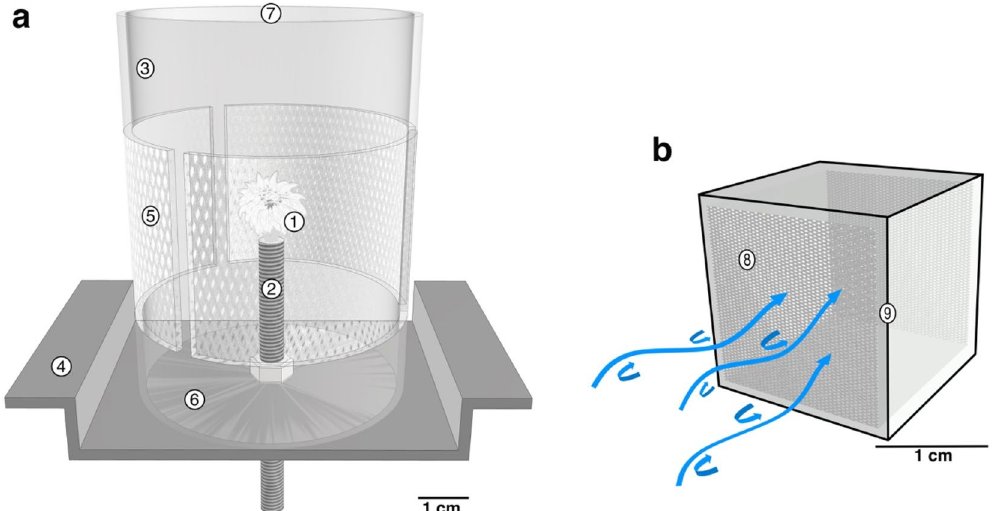
Figure 8. Schematic drawing of the ( a ) cylindrical plastic container and the ( b ) flow-through cube in the holding tank. ( a ) Reproductive polyp (1) glued onto a polyethylene screw (2), and placed in a cylindrical (7.2 cm high, 5.4 cm ø) plastic container (3), which was screwed onto a plastic holder (4). The plastic container had three side windows covered with mesh (100 µm) (5) to allow water exchange. A closed bottom (6) and an open top (7), which rose 1 cm above the water surface ensured retention of larvae. ( b ) Larvae collected from the container were placed into a cube with the upstream and downstream side covered with a 100 µm mesh (8), whereas the top, floor and walls consisted of coverslips glued with silicone (9, black line). Blue arrows indicate the direction of the water flow with eddies and